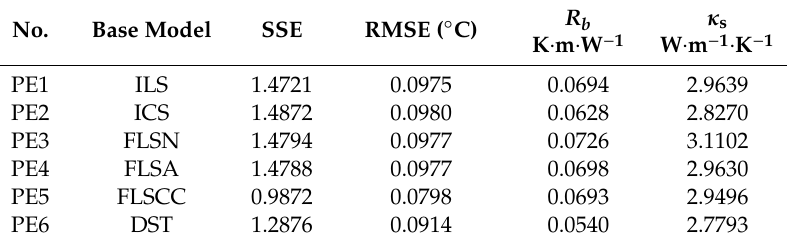
Table 1. Results of TRTPE using di ff erent